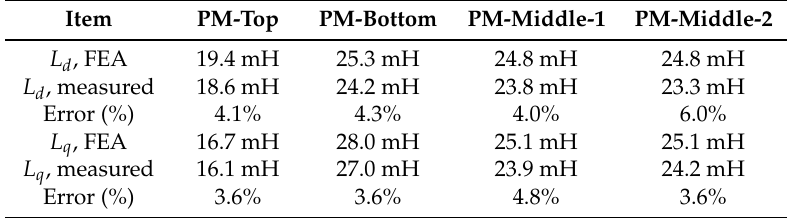
Table 7. Comparison of The 3D FEA calculated and measured dq -axis inductances.